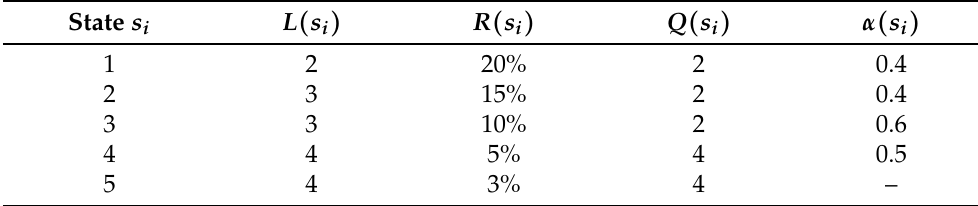
Table 1. CS-JPEG coding